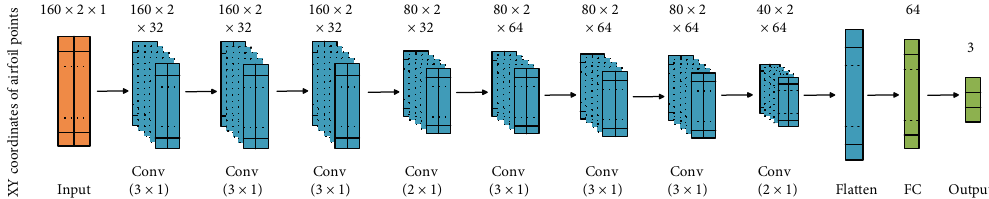
Figure 2: Basic skeleton of convolutional neural network. Table 1: The architectures of the proposed neural network.